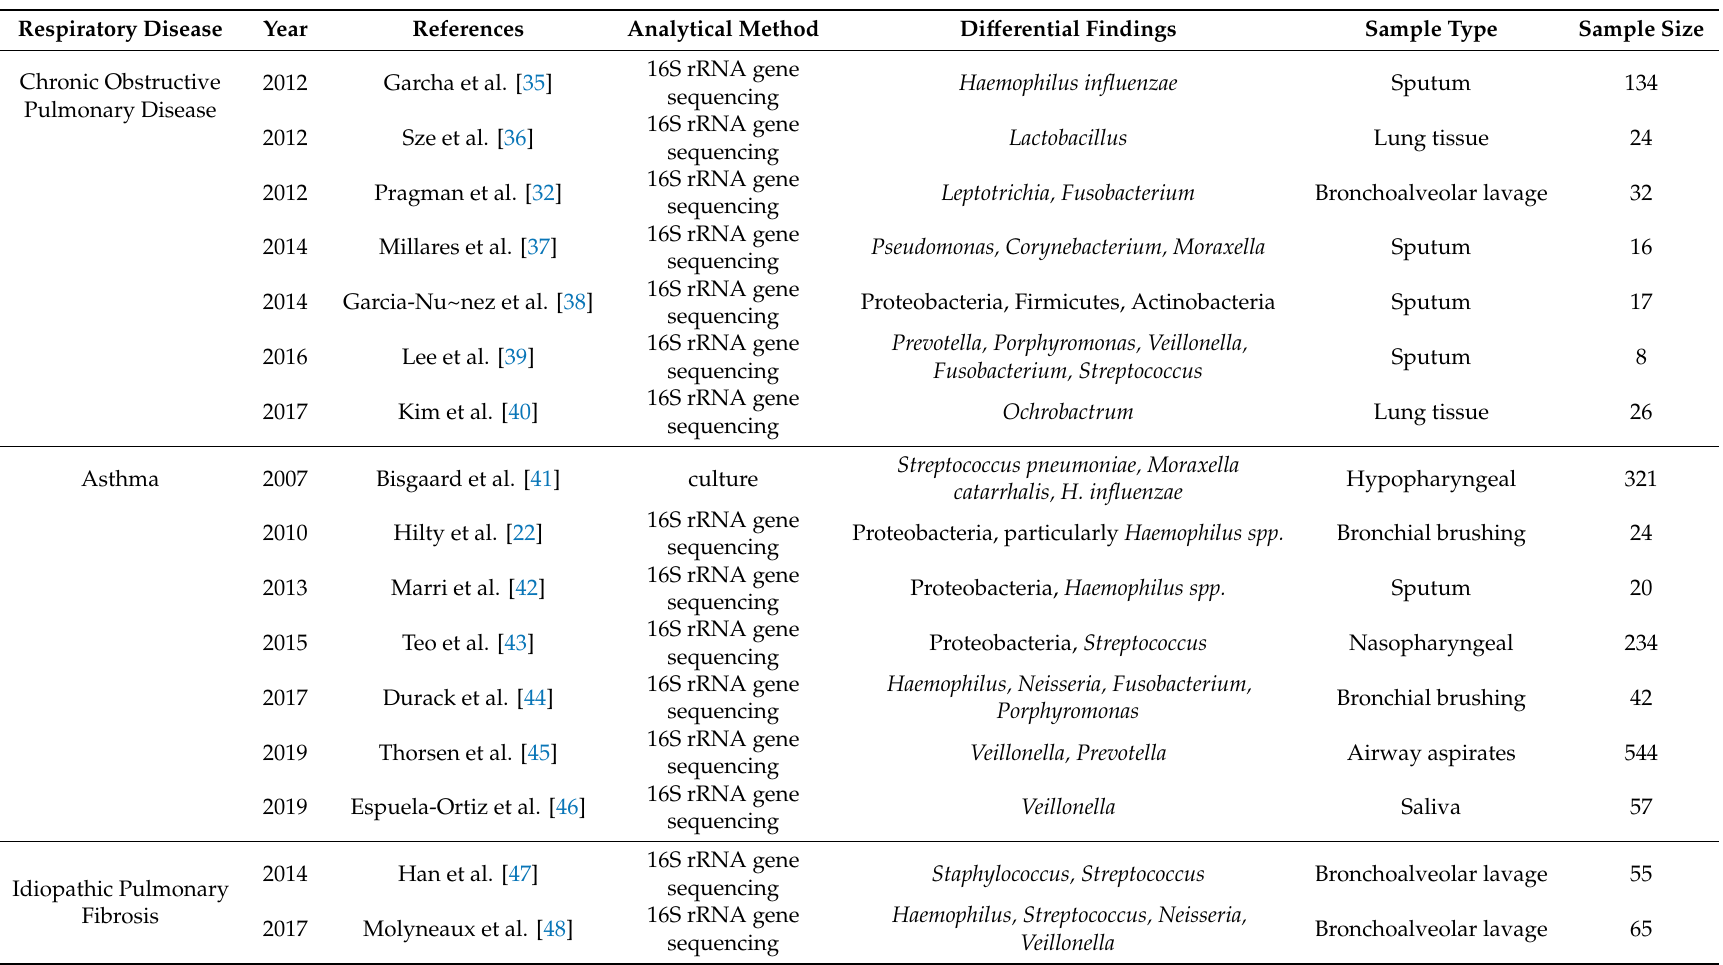
Table 2. Relationship between lung microbiota and lung